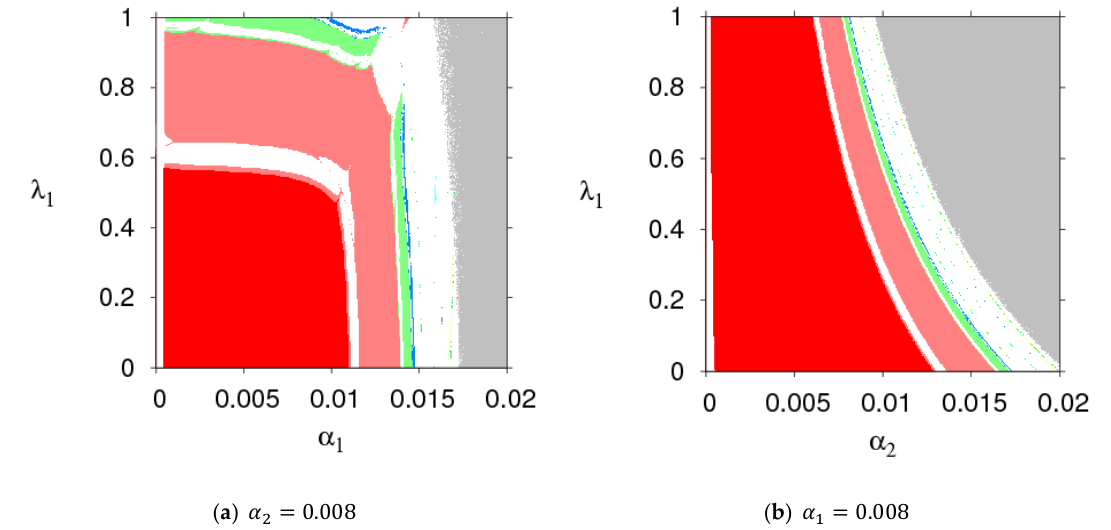
Figure 10. The parameter basins of dynamic System (7) in the planes of (𝛼 1 ,𝜆 1 ) and (𝛼 2 , 𝜆 1 ).